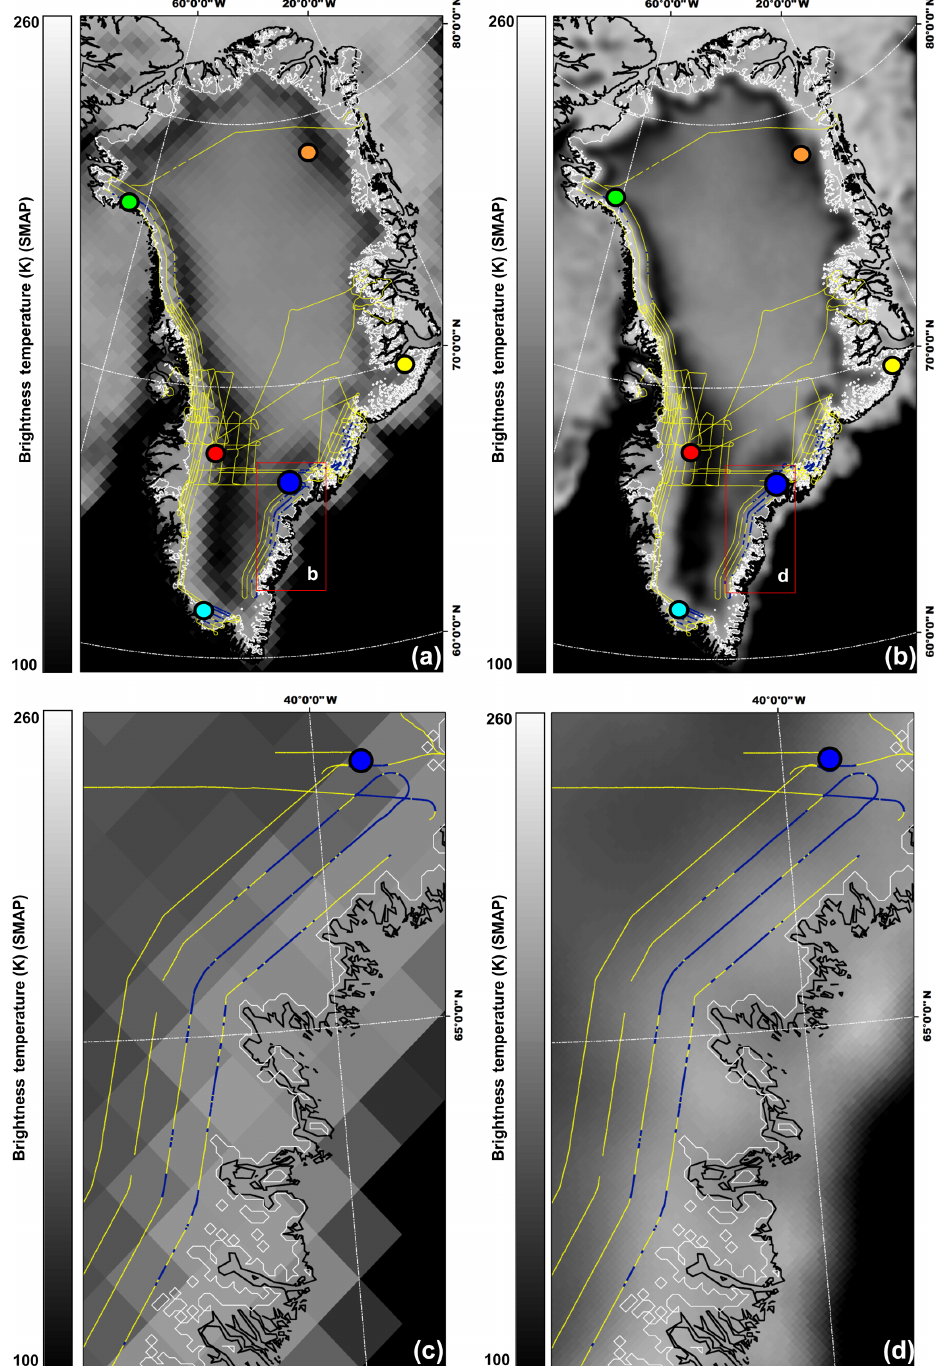
Figure 1. (a) Gridded (25km) and (b) enhanced-resolution (3.125km) V-pol L-band T B images collected 15 April 2016 by the microwave radiometer on the SMAP satellite during the evening orbital pass interval over Greenland (Long et al., 2019). Black and dark grey regions of low L-band T B values are Greenland’s percolation facies. Zoom areas (red boxes, c and d ) are 2016 MCoRDS-derived perennial firn aquifer locations (small blue circles) in the southeastern percolation facies along OIB flight lines (yellow lines). Test site 1 (blue circle); test site 2 (cyan circle); test site 3 (red circle); test site 4 (green circle); test site 5 (orange circle); test site 6 (yellow circle); GIMP-derived ice extent (white lines; Howat et al., 2014); coastlines (black lines; Wessel and Smith, 1996). Several shallow firn core sites where meltwater was found stored at depths of 10, 12 and 25m throughout the freezing season (Forster et al., 2014) are within the test site 1 grid